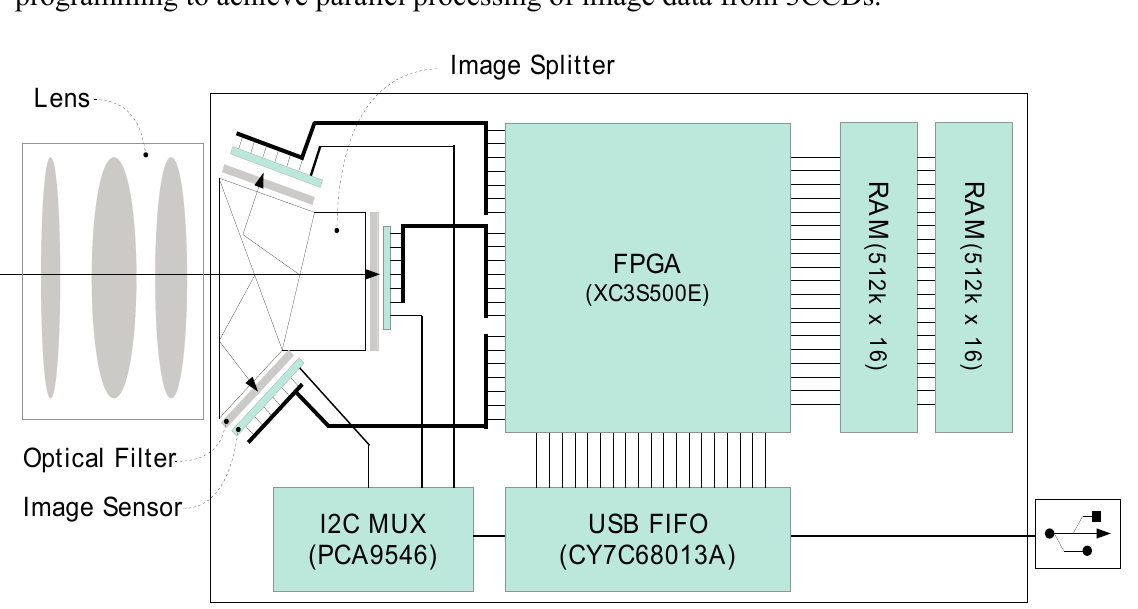
Figure 1. The schematic layout of critical components of the portable multispectral 3CCD camera. Design and development include in-house fabrication of the beam-splitter prism assembly, integration of the electrical components on printed circuit boards, and firmware programming to achieve parallel processing of image data from